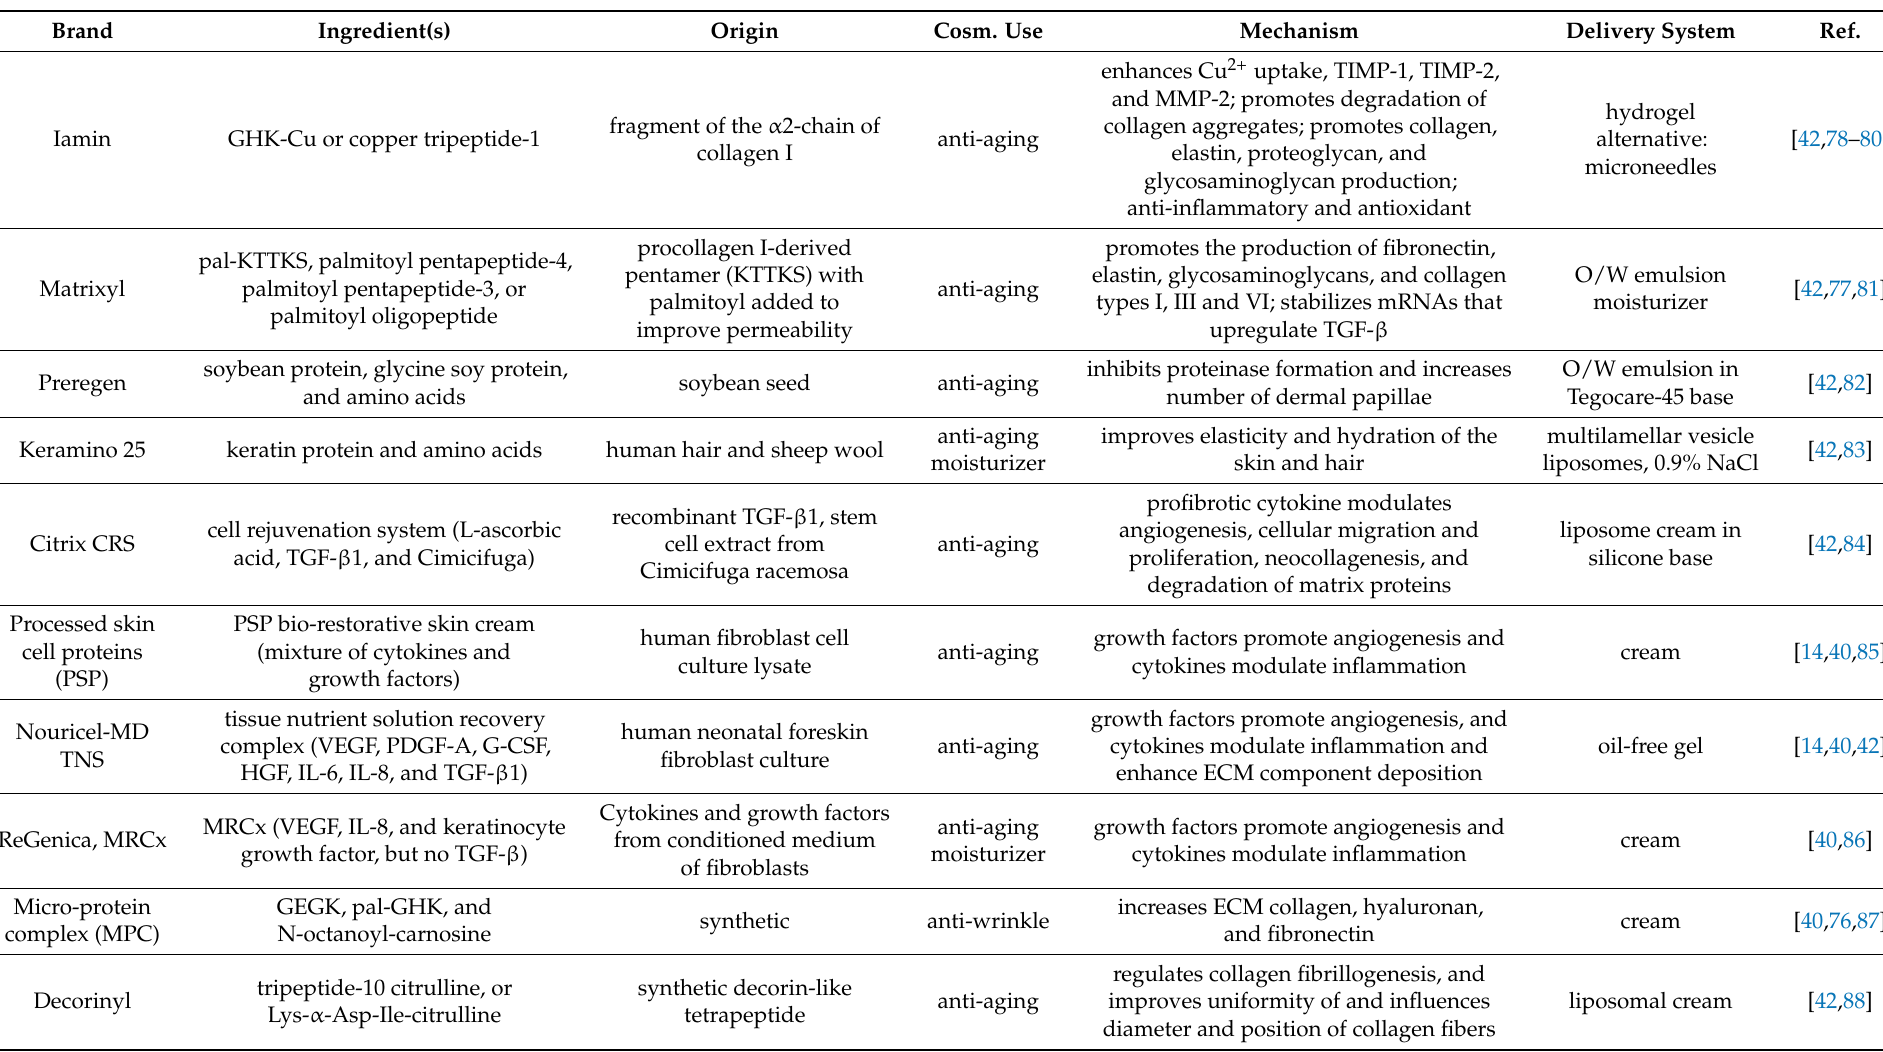
Table 1. Products containing matrikines and matrikine-like